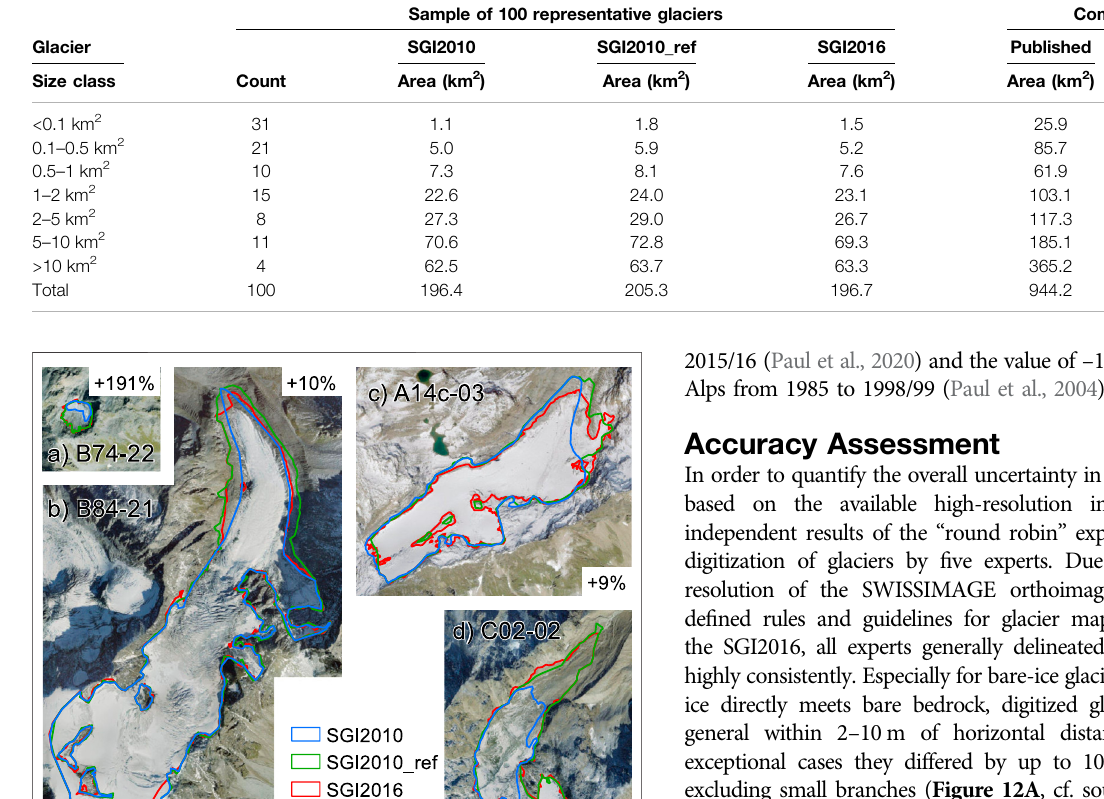
TABLE 5 | Results of the SGI2010 re-digitization experiment and upscaling to all Swiss glaciers. Sample of 100 representative glaciers